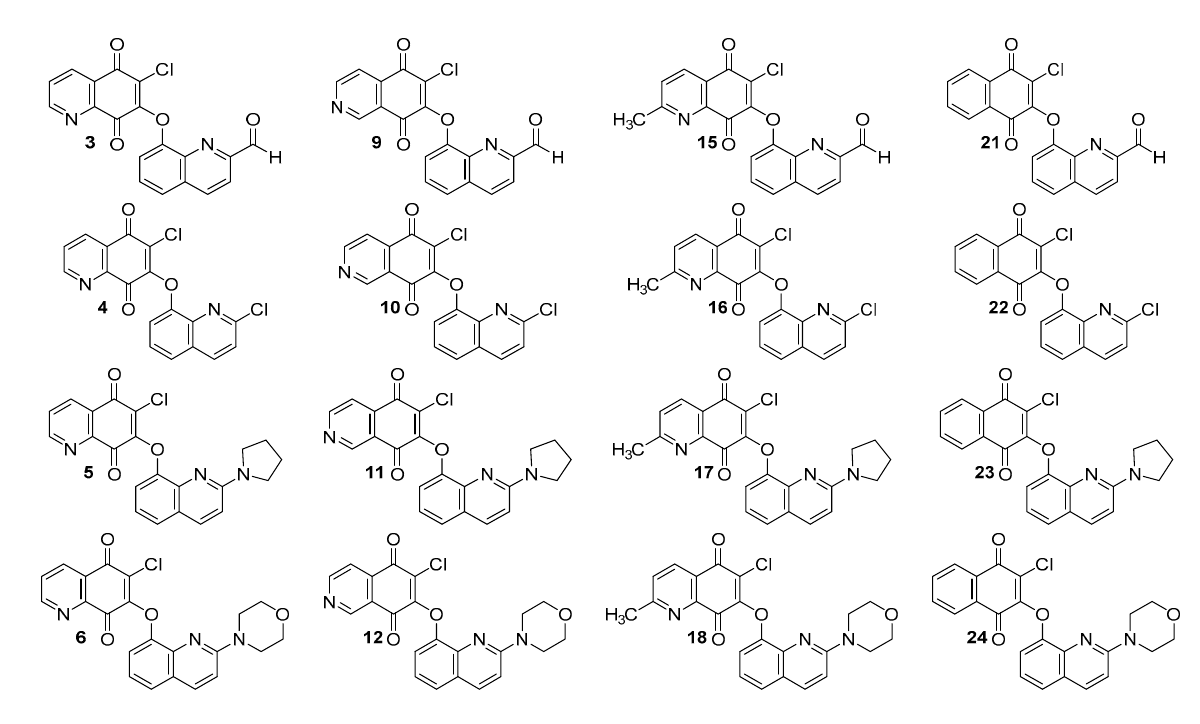
Figure 2. Chemical structure of hybrids 1 – 24 .